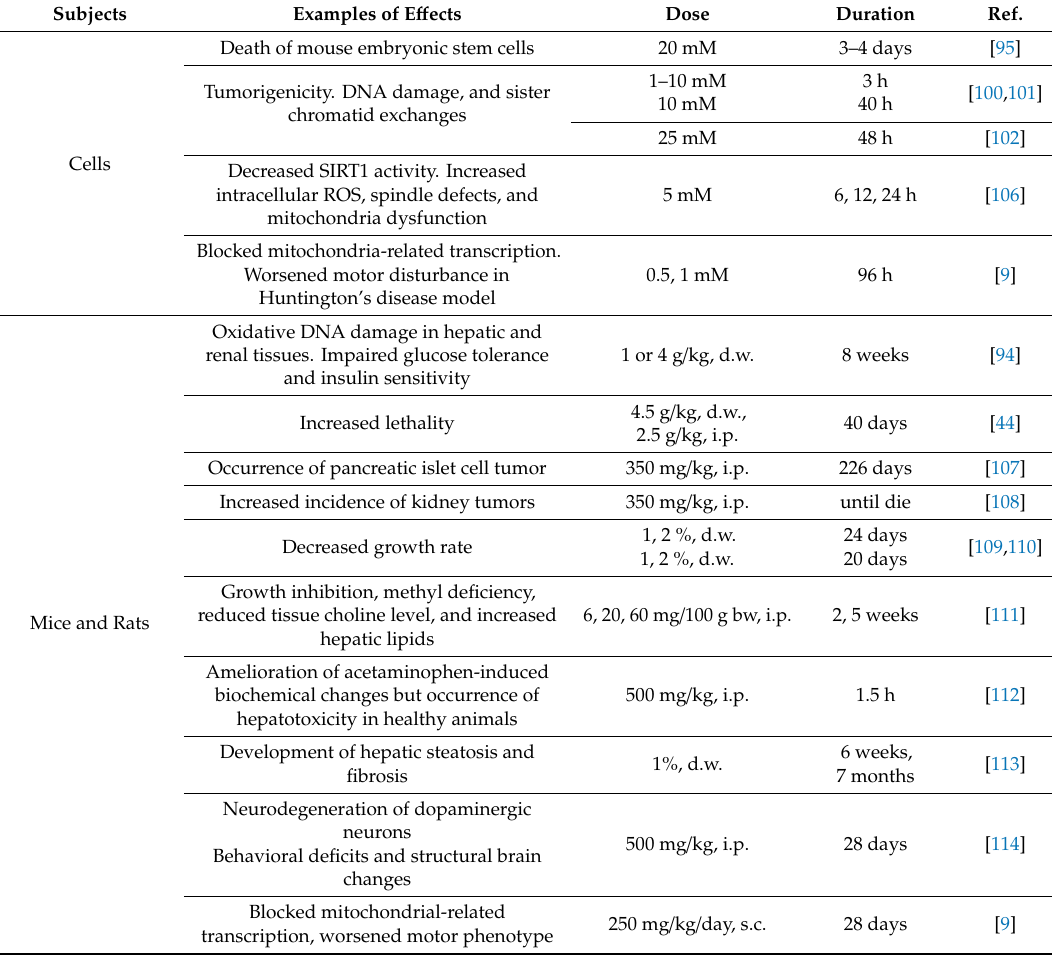
Table 3. Examples of adverse e ff ects of high dose NAM reported in studies of cells and